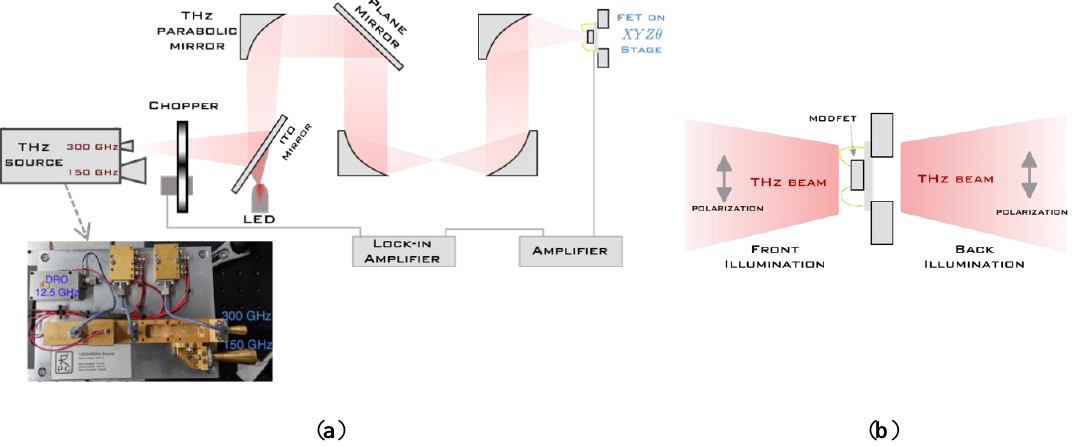
Figure 2. ( a ) Schematic description of the experimental setup: a solid-state sub-THz source by RPG (RPG-Radiometer Physics GmbH, Meckenheim, Germany) (shown in the bottom left corner) generates two output frequencies 0.15 and 0.3 THz; ( b ) Detail of the schematic of the FET detector mounted on a x-y stage with both configurations and where the THz rays polarization is highlighted.